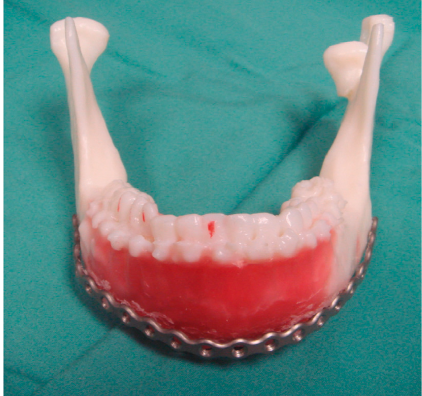
Figure 2: Fracture reduction performed following angle mandible osteotomy and then waxing-up to allow adaptation of the re- construction plate. Note that there is loss of left posterior facial height secondary to condylar neck